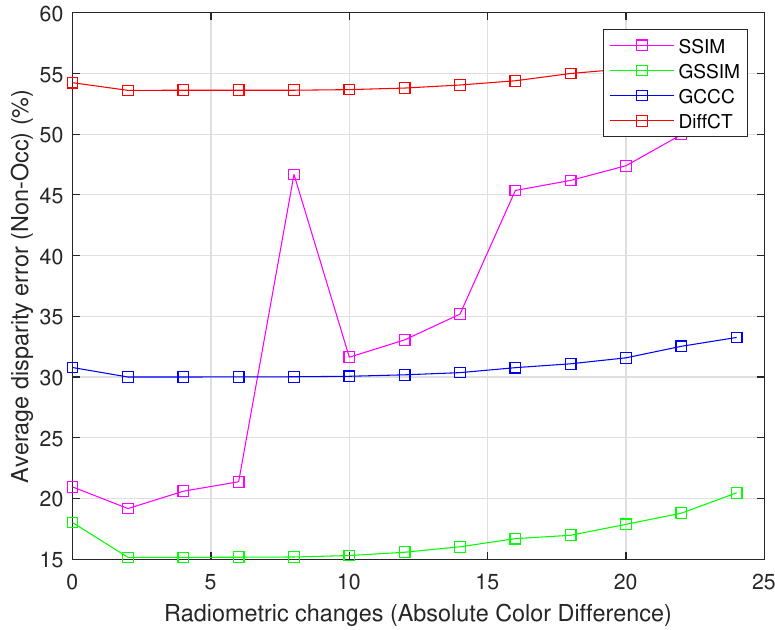
Figure 3. The disparity results obtained with respect to radiometric distortions for all of the presented cost functions, for KITTI 2012 training